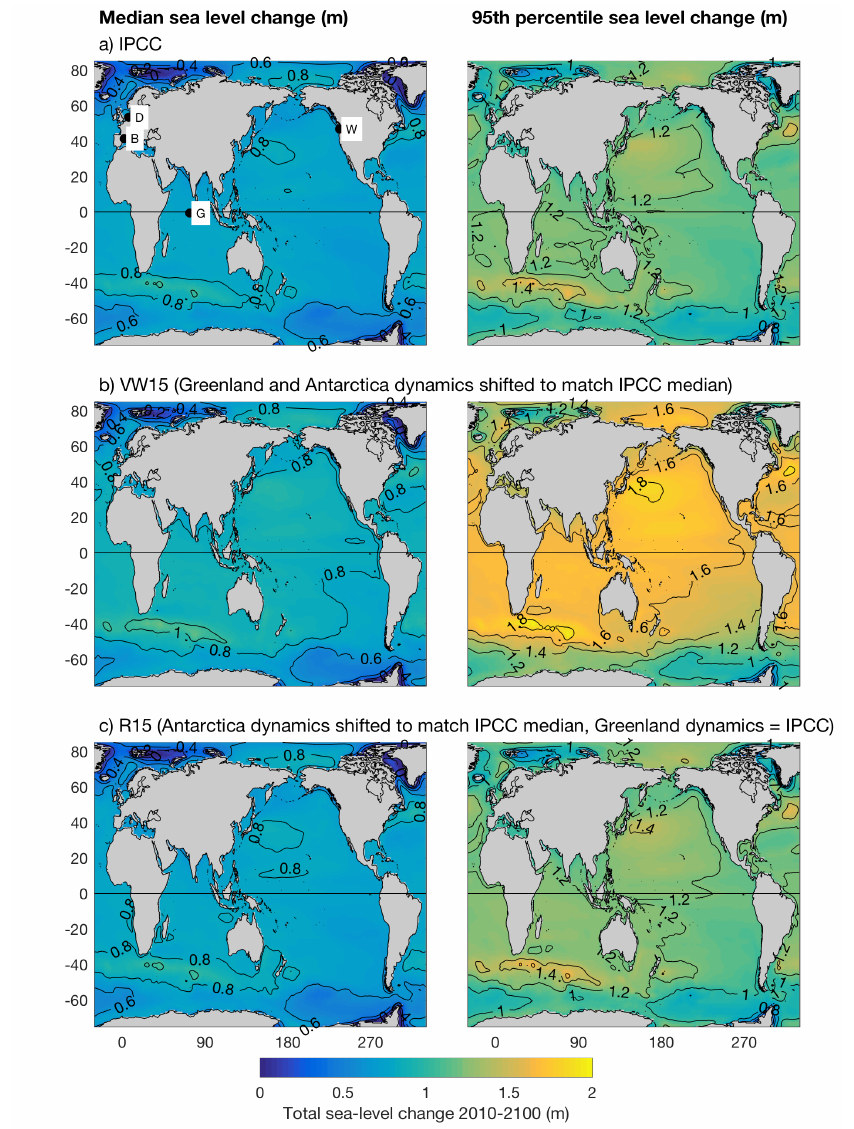
Figure 5. Projected cumulative sea-level change (m) for 2010–2100; median (left column) and 95th percentile (right column). All projections have the same median for the projected individual dynamical ice sheet contributions to SLR but a different shape of the uncertainty distribution. ( a ) IPCC; ( b ) VW15; ( c ) R15. The locations of the tide gauges in Figure 2 are indicated in ( a ) by their first